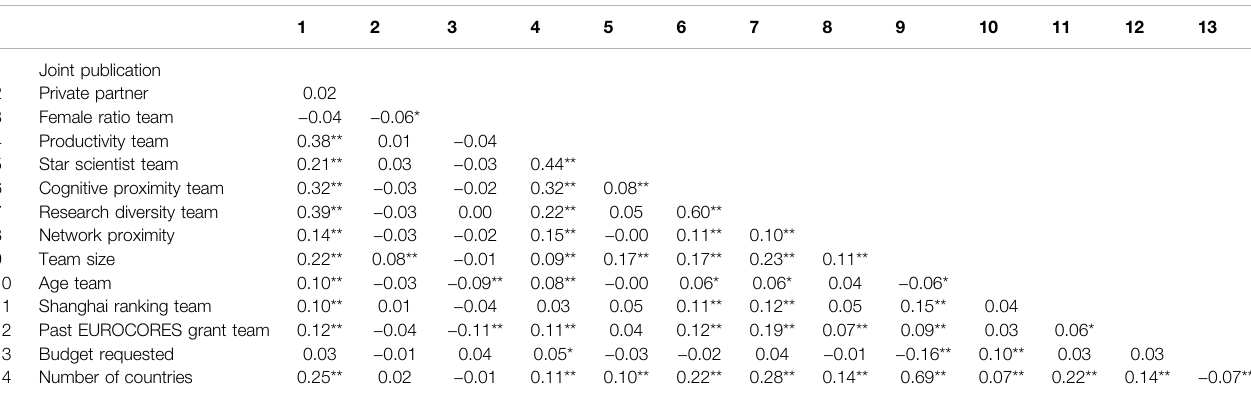
TABLE 7 | Pairwise correlation